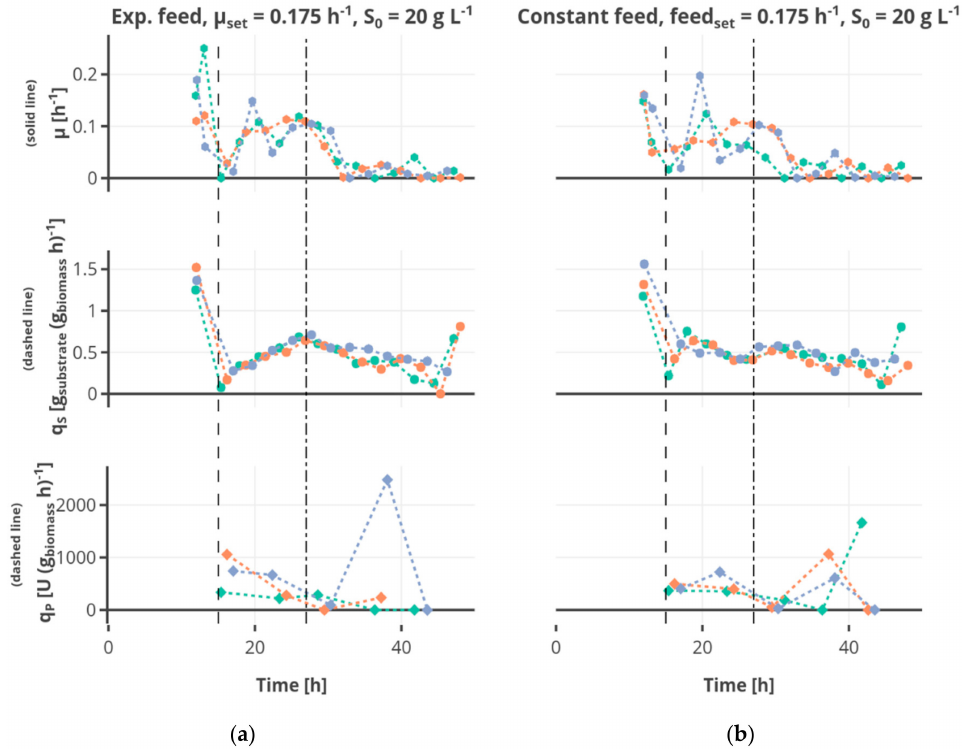
Figure 6. Specific rates for growth rate µ , substrate consumption q S and product formation q P are shown regarding ( a ) exponential feed at a feed rate of 0.175 h − 1 , an initial substrate concentration S 0 of 20 g L − 1 and no hunger phase, and regarding ( b ) constant feed at a feed rate of 0.175 h − 1 , an initial substrate concentration S 0 of 20 g L − 1 and no hunger phase. The rates are calculated using the mean of the respective measurements. The three MBR cultivations performed under the same conditions are shown in different colors, the start of the feed and the constant fed-batch phase are shown by the vertical dashed, respectively dashed-dotted line. Interactive versions of the plots can be found online